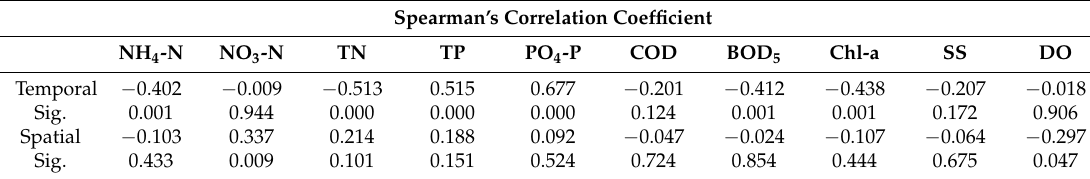
Table 5 . Correlation coefficient of Spearman’s correlation analysis for water quality. Table 5. Correlation coefficient of Spearman’s correlation analysis for water quality.